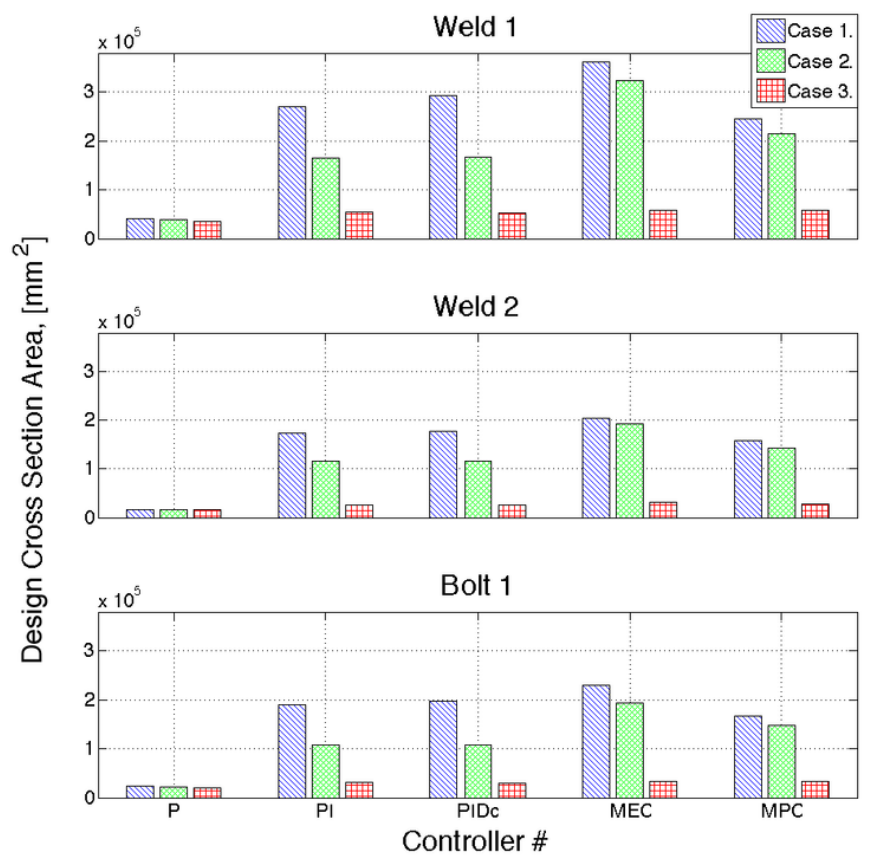
Figure 9. Design cross section areas for the three different connections defined in Figure 7 for different control strategies as well as different implementation forms (Cases).